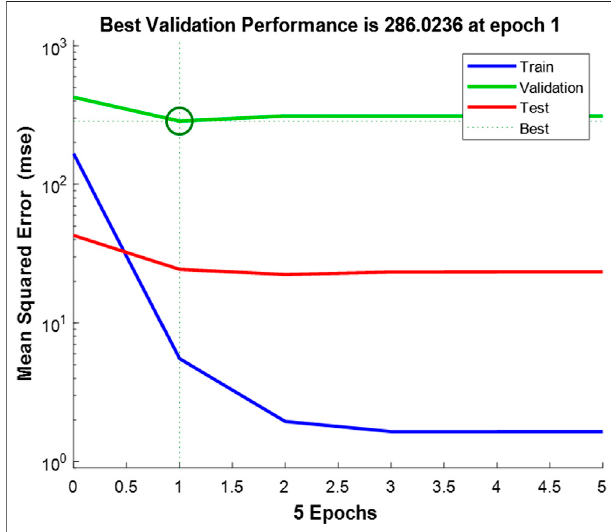
FIGURE 9 | Performance-plot of the selected network.